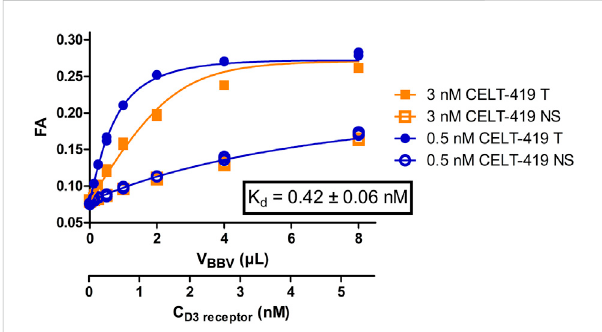
FIGURE 2 Binding curves of CELT-419 binding to D 3 receptors in BBVs. FA of 3 nM (orange squares) or 0.5 nM (blue circles) CELT-419 were measured after 2 h incubation with different amounts of D 3 receptor displaying BBVs. Non-speci fi c binding (NS, open symbols) was determined in the presence and total binding (T, fi lled symbols) in absence of 50 μ M Spiperone. The displayed fi t, the concentration of D 3 receptor binding sites and the K d values were calculated post hoc from the results of these experiments using the model described in (Veiksina et al., 2014). K d ± SEM is the weighted average of three independent experiments performed in duplicates. Representative experiment performed in duplicates is shown, with both duplicates